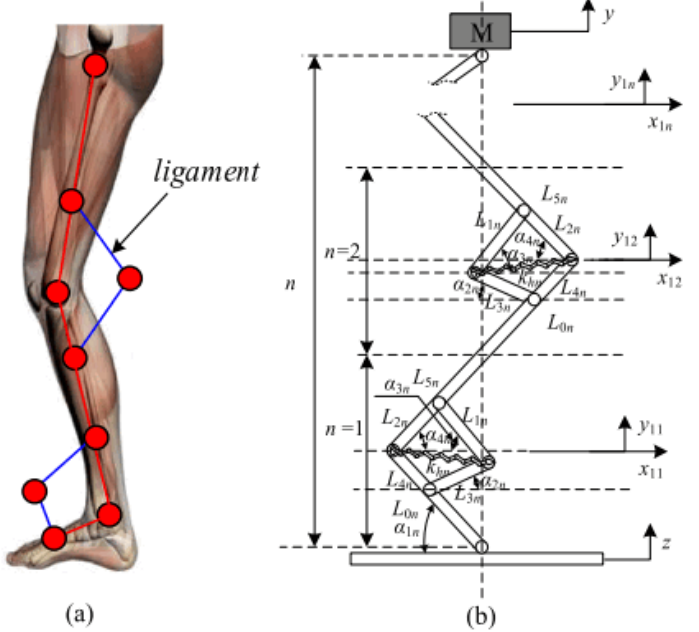
Figure 10. ( a ) Schematic of human leg ( b ) multi-joint bionic vibration control device [56].